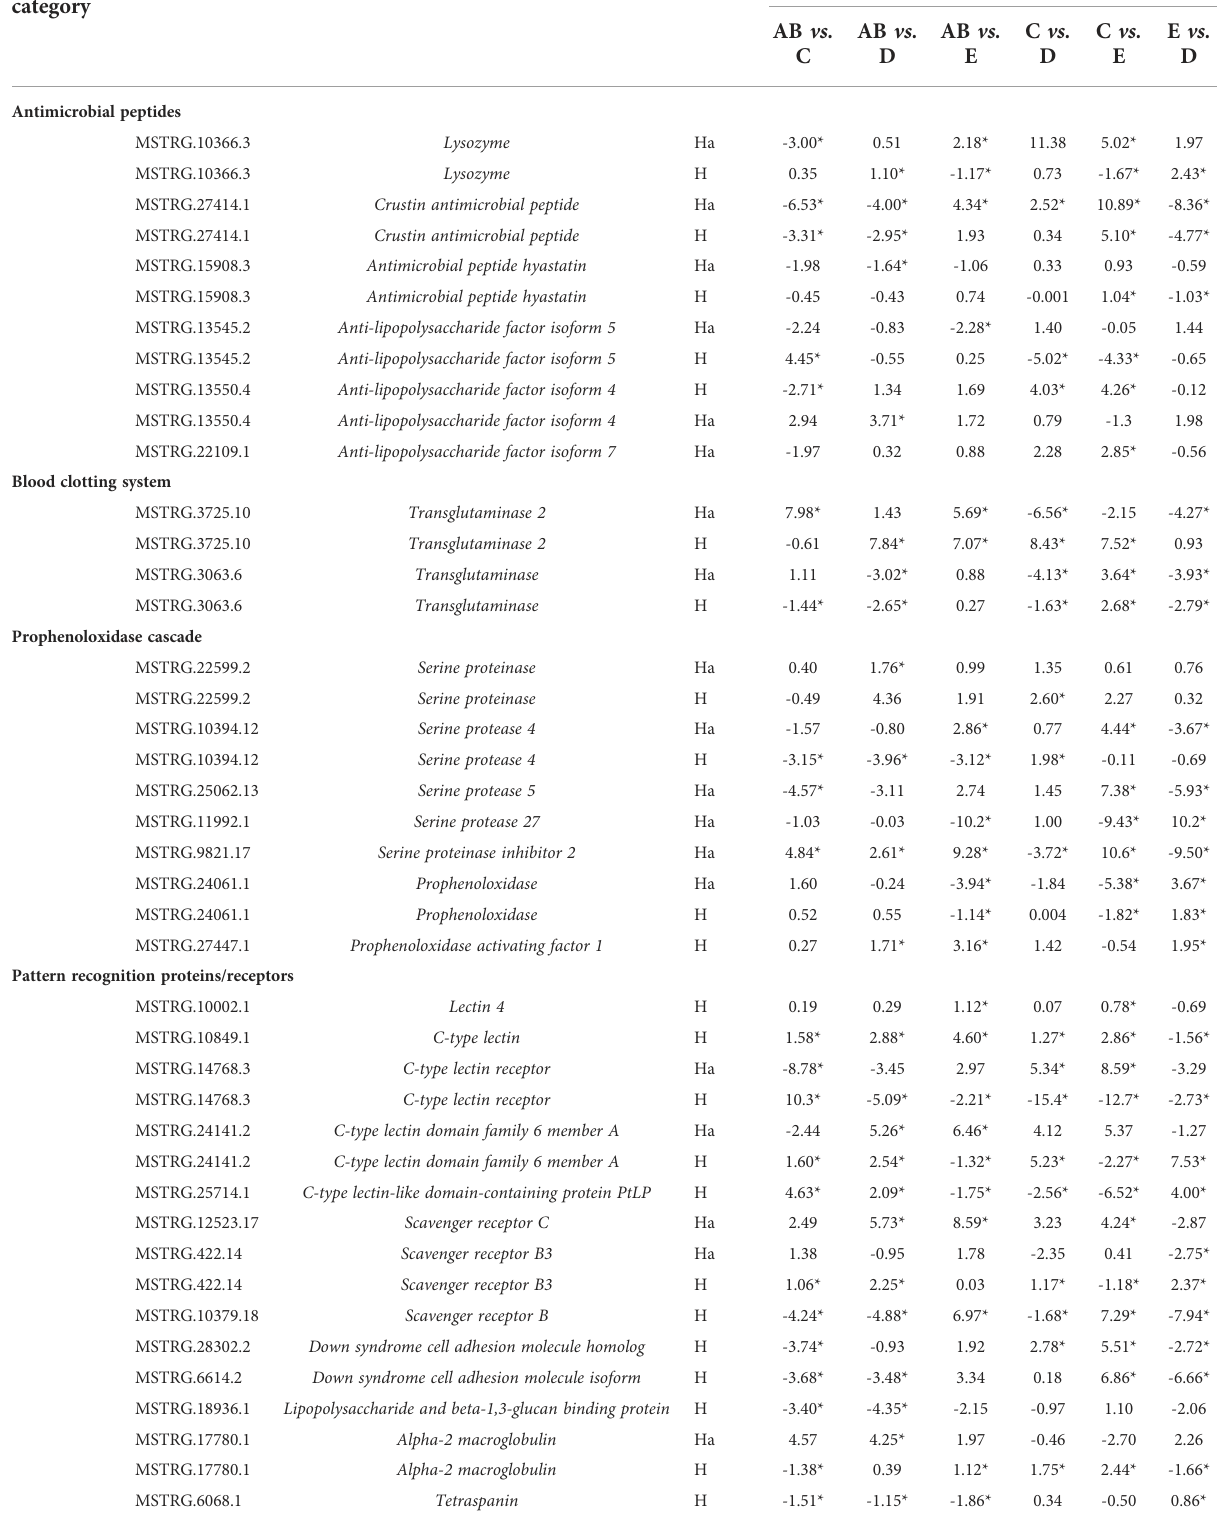
TABLE 5 Summary of differential expressed genes related to immune in the transcriptome of P. trituberculatus . Functional